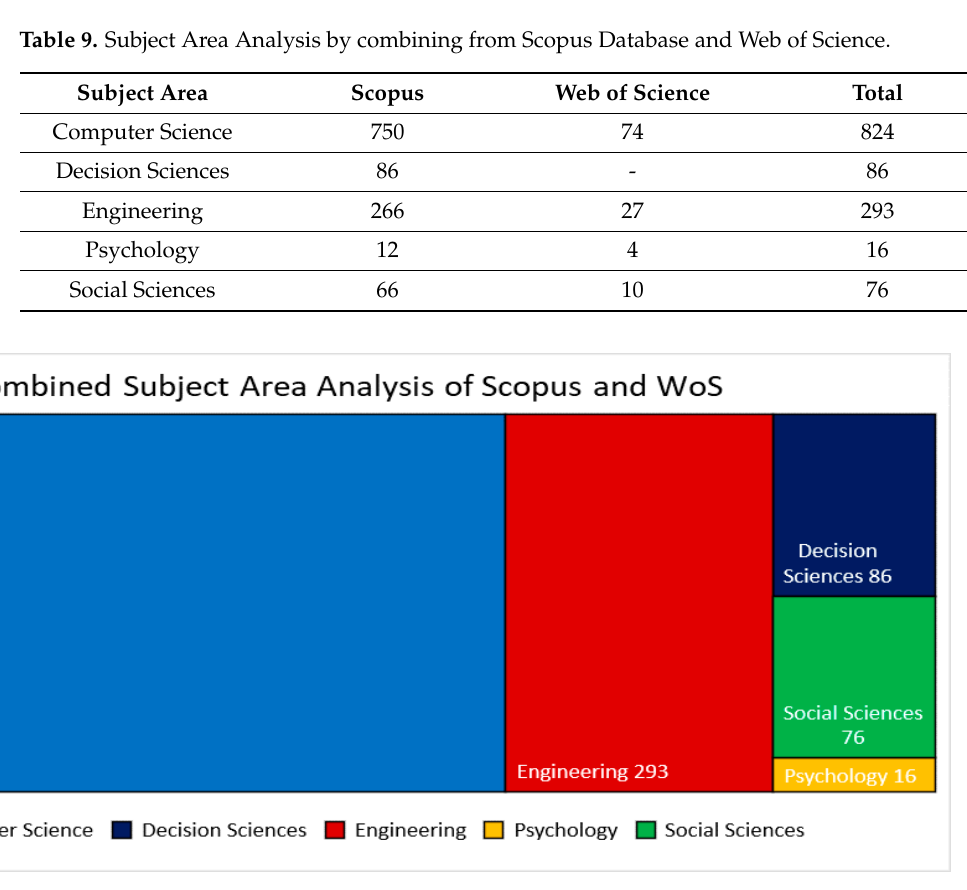
Figure 7. Categorization of research done in various subject areas combined from Scopus and Web of Science. Table 9. Subject Area Analysis by combining from Scopus Database and Web of Science.